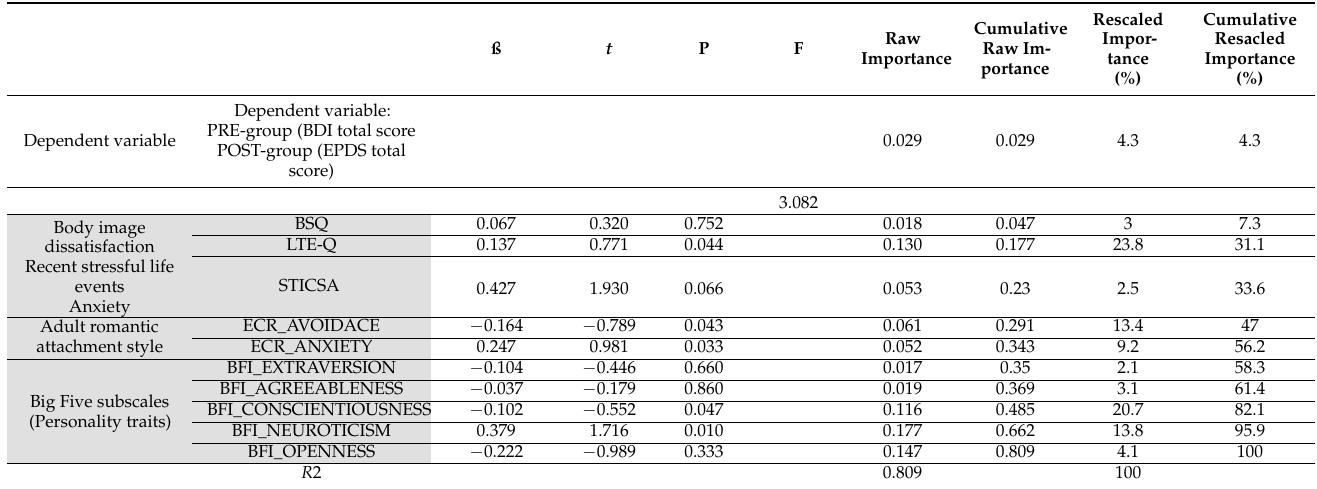
Table 6. Hierarchical Regression (HR) and Relative Weight Analysis in the POST-partum group. ß t P F Raw Importance